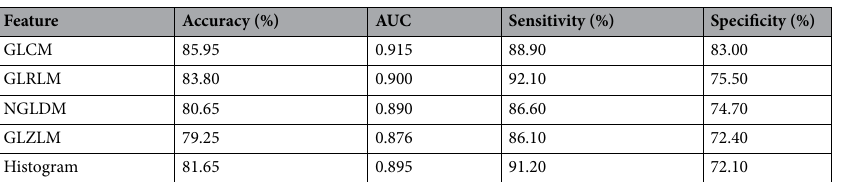
Table 1. The classification results of COVID-19 and other pneumonias with different features (GLCM, GLRLM, NGLDM GLZLM and histogram features) as model inputs, respectively.